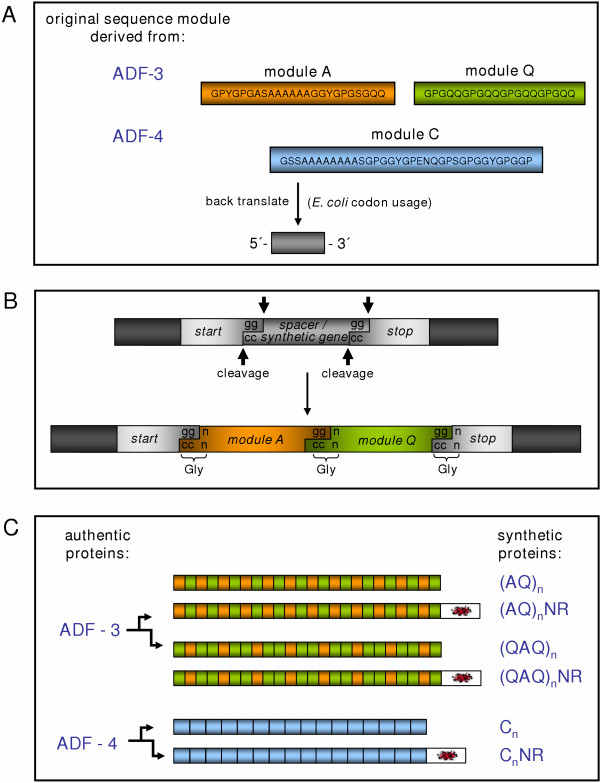
Cloning strategy for constructing synthetic spider silk genes. (A) Amino acid sequences of designed silk modules were derived from dragline silk proteins ADF-3 and ADF-4 and back translated into nucleotide sequences using the bacterial codon usage. (B) The cloning cassette comprised restriction sites required for module insertion and multimerization. During gene construction a spacer region was replaced by modules and module multimers. The first codon of each module (ggn) determined the "linking" amino acid glycine. (C) Single modules were connected resulting in controlled assembly of synthetic genes. To study different length repeat units, one or two Q modules were combined with one A module to obtain (AQ) or (QAQ). These repeat units were multimerized to generate synthetic genes coding for the repetitive proteins (rep-proteins) (AQ)n and (QAQ)n. The repetitive part of ADF-4 is generally composed of a single consensus module termed C, which was multimerized to obtain the rep-protein Cn. Additionally, carboxyl-terminal non-repetitive (NR)-regions from the natural genes were amplified by PCR and optionally linked with the synthetic genes [50].